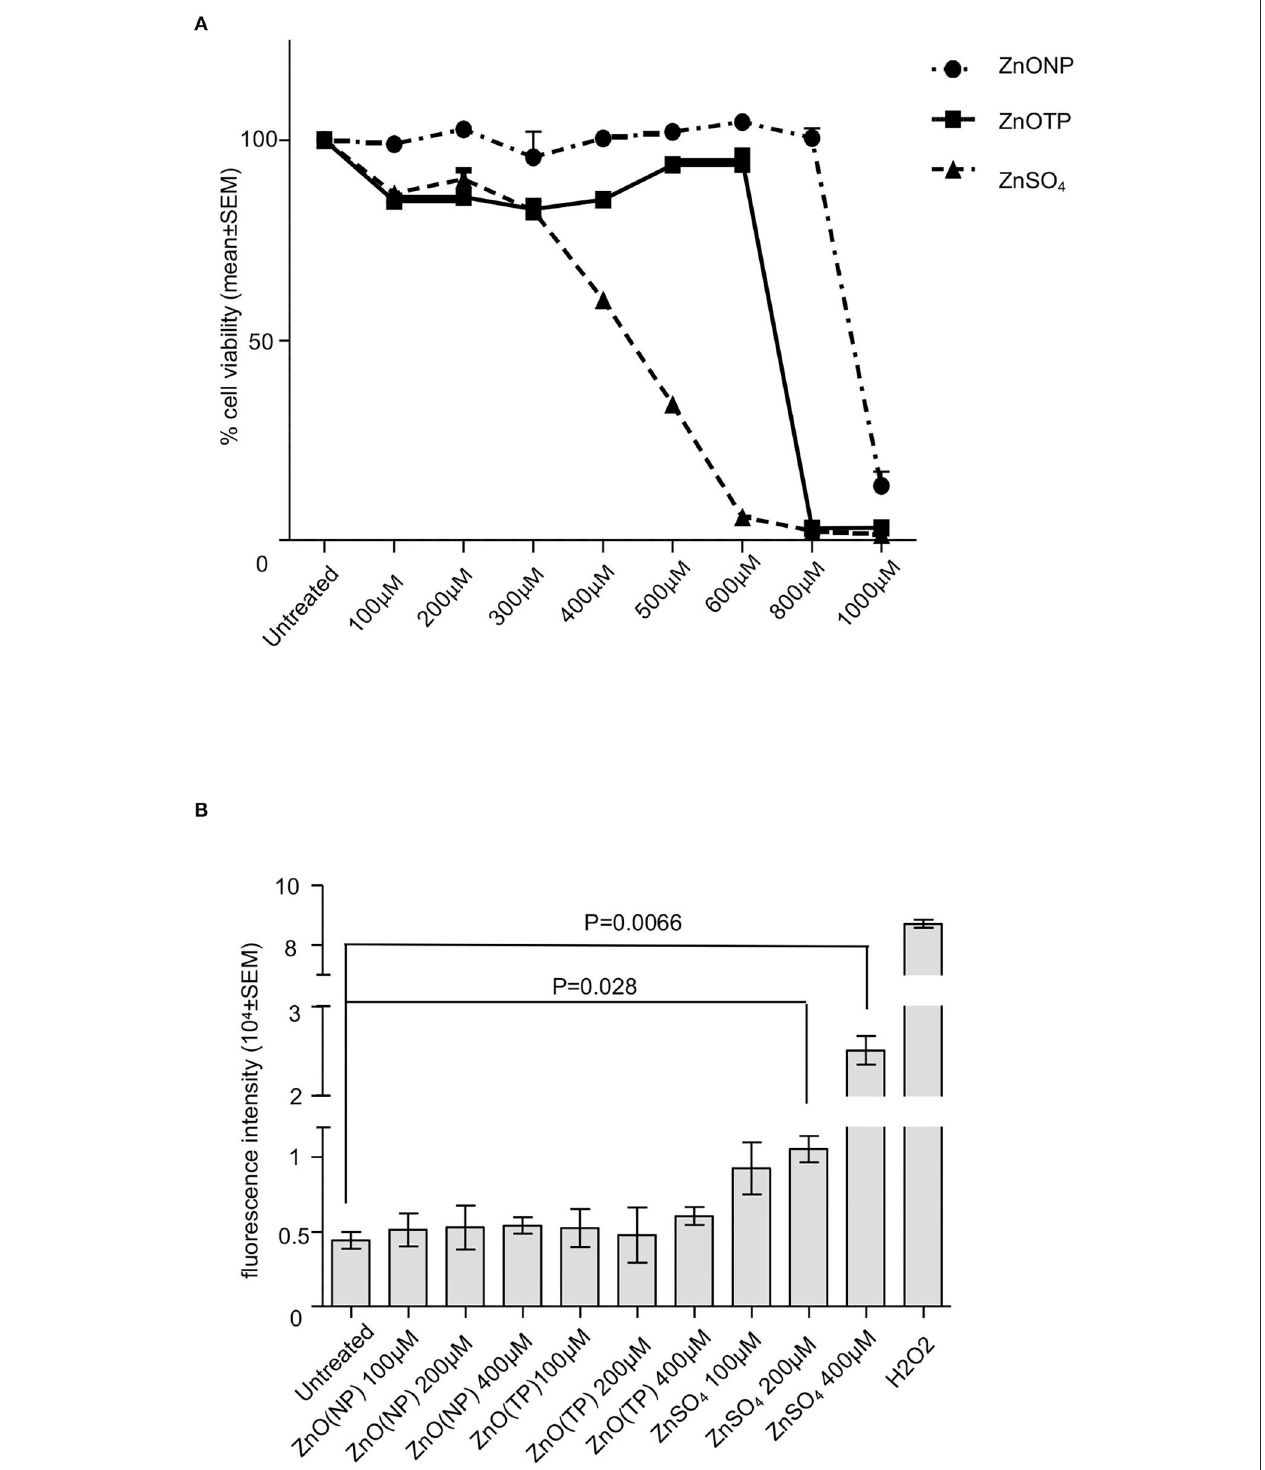
FIGURE 2 | Characterization of ZnO(NP) and ZnO(TP) in mammalian cell culture. (A) Percentage viability of Huh7 cells treated for 24h with increasing dose of ZnO(NP), ZnO(TP), and ZnSO 4 , as indicated. The values for the untreated sample were considered to be 100%, and all other values were calculated with reference to that. Values are mean ± SEM of three independent experiments. (B) Estimation of reactive oxygen species (ROS) level in Huh7 cells treated with the different concentration of ZnO(NP), ZnO(TP), and ZnSO 4 for 6h. Measured fluorescence intensity was proportional to ROS generation. The mean ± SEM values of triplicate samples are